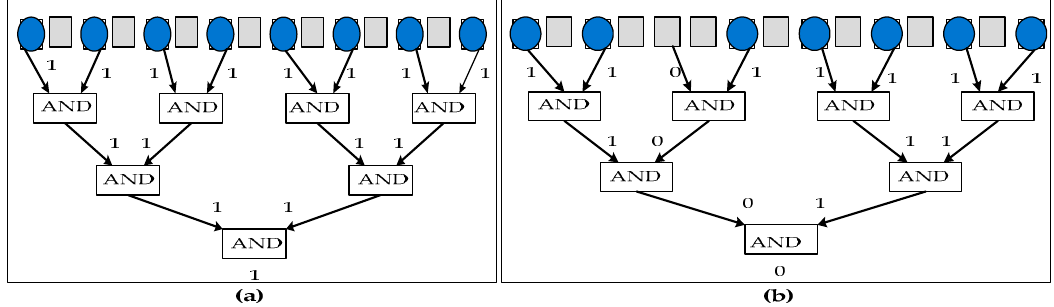
Figure 6. Microfluidic compactor used for parallel scan like testing with gray boxes representing electrodes, blue circles represent the test droplets and the arrows represent the output of AND logic gate being fed to the input of another AND logic gate: ( a ) compactor output = “1” which represents the test droplet at the sink electrode and the DMFB is defect free ( b ) compactor output = “0” which represents the absence of test droplet at the sink electrode and the DMFB is faulty [47].